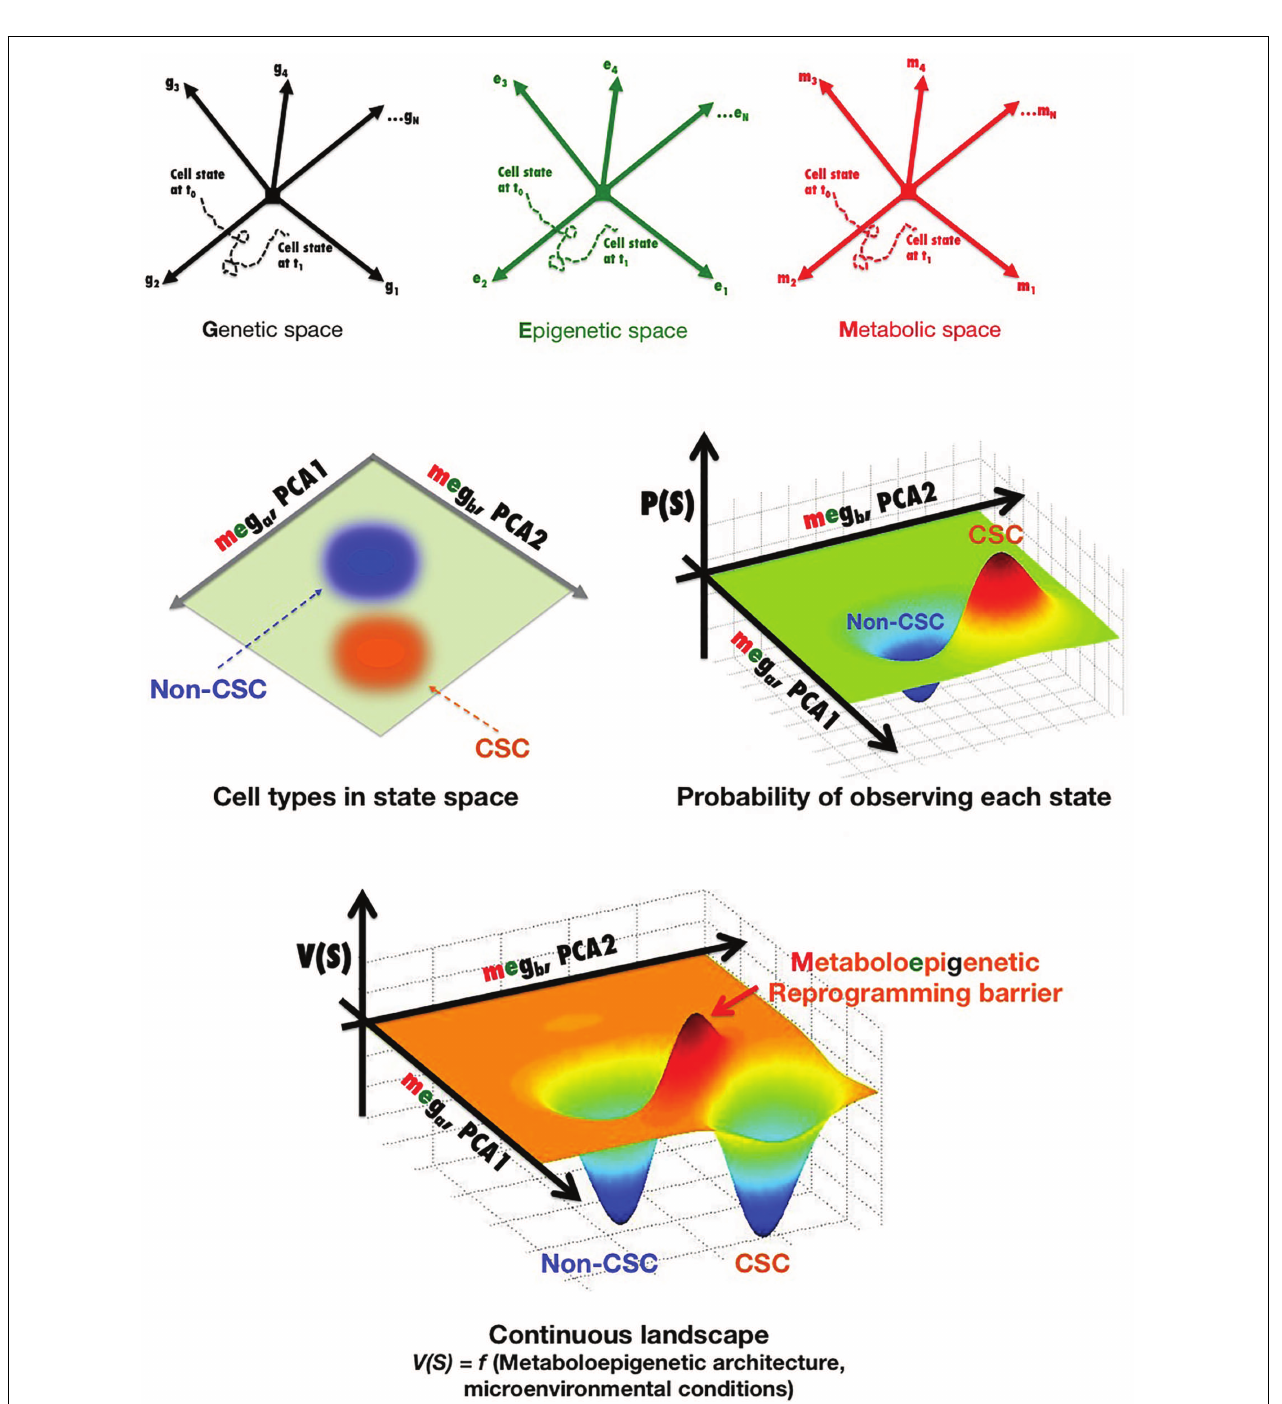
FIGURE 2 | Metabostemness: developing probabilistic descriptions of non-CSC and CSC cell states . (See text for a more detailed explanation).